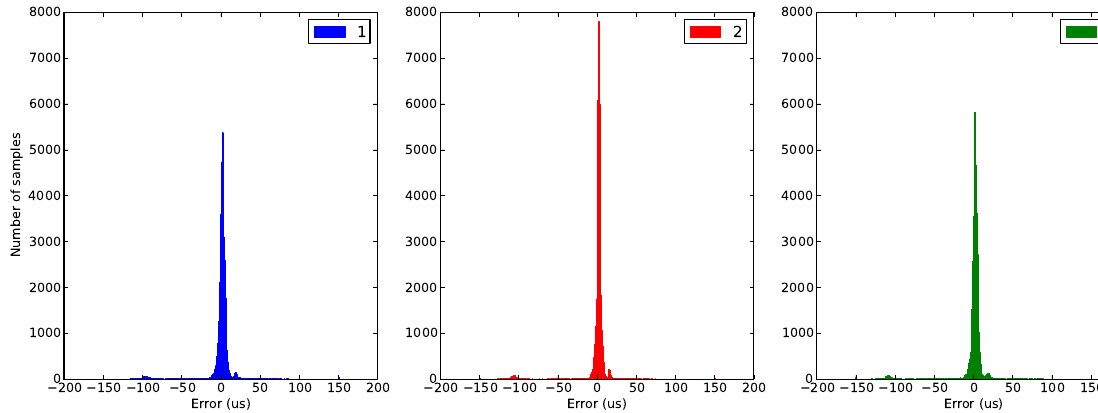
Figure 13. Histogram of differences between clock sources (1 us buckets). Table 3: Sampling time accuracy among 3 nodes